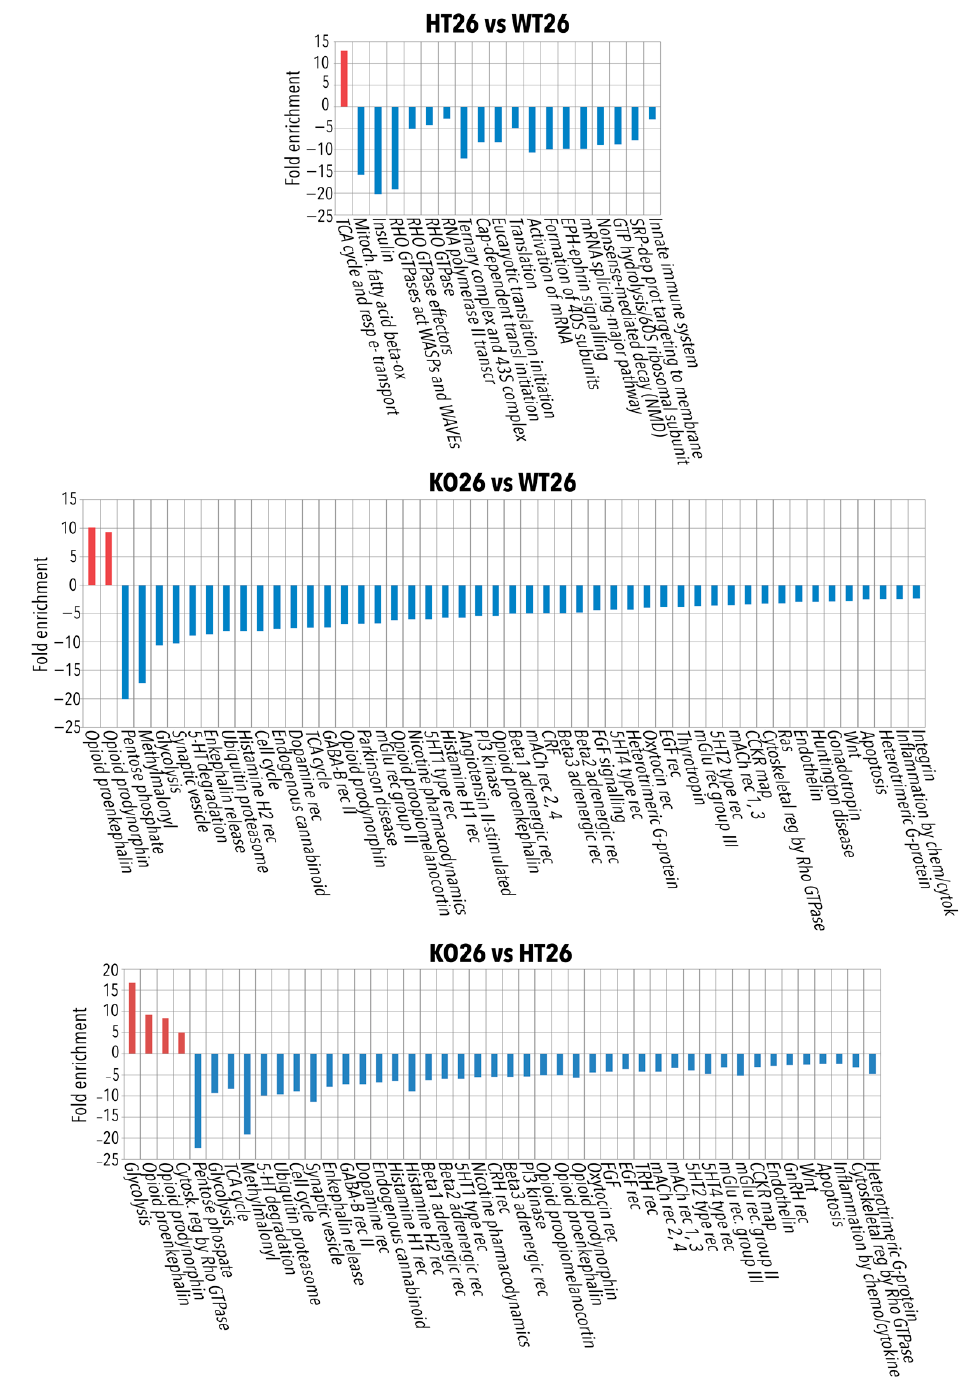
Figure 5. Panther pathways analysis of the proteins differentially or exclusively expressed in HT26 vs. WT26, KO26 vs. WT26 and KO26 vs. HT26. Bioinformatic analyses were conducted by Panther software (release 16.0) to cluster enriched Panther pathway within the set of differentially expressed or exclusively expressed proteins in HT26 vs. WT26, KO26 vs. WT26 and KO26 vs. HT26. If any Panther pathways enrichment was found, the data were processed by Panther Reactome to find Reactome GO and pathways enrichment. Functional grouping was based on Fischer’s exact test p ≤ 0.05 and at least three counts.